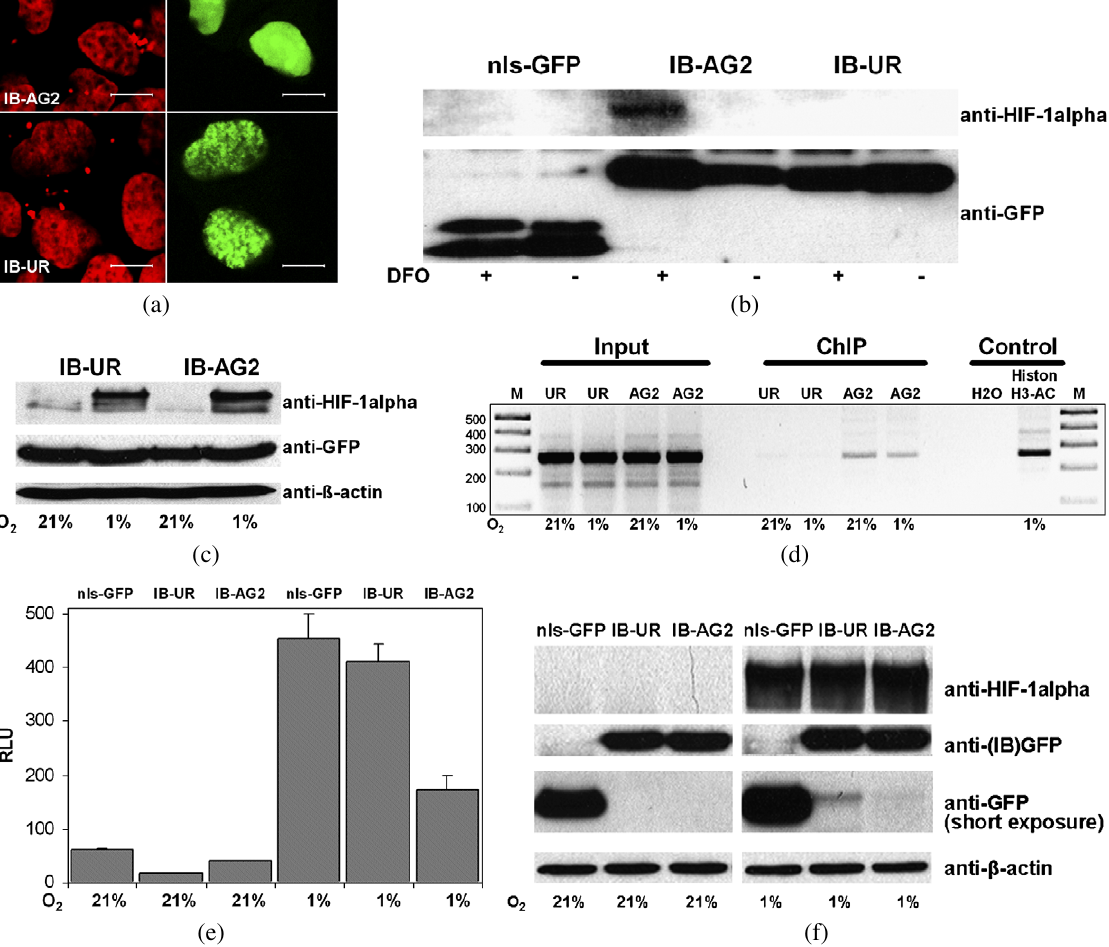
Fig. 4. Characterization of HIF intrabodies. (a) Immunofluorescence confocal microscopy with cultured U2OS cells transfected with either nuclear localized GFP fused IB-AG2 or control IB-UR intrabodies, DNA is stained with TO-PRO-3 (dark-grey/red ∗ ), scale bar = 10 µm. (b) Western blot analysis of Ni-NTA intrabody pull down of HeLa cell lysates transfected with IB-AG2, IB-UR or nls-GFP un – or stimulated with DFO. (c) U2OS cells were transfected with either IB-AG2 or IB-UR and 24 h after transfection exposed to normoxia (21%) or hypoxia (1% O 2 ) for 24 h. Separate culture dishes were used for either protein expression analysis for input with HIF-1 α , GFP and β -actin, or subjected to ChIP. (d) Ethidium bromide stained gel with PCR products from GFP ChIP isolates from IB-AG2 or control IB-UR transfected cells on endogenous EPO promoter. (H 2 O as a negative control and as positive control ChIP with anti-acetyl-Histone H3 antibody.) (e) HIF reporter assay with HRE-EPO-luc in U2OS cells transfected with IB-AG2 or control intrabody, IB-UR. IB-AG2 inhibits hypoxia induced HRE activity. All luciferase experiments were performed in triplicate and values were corrected for TK-renilla expression. Error bars represent mean + SD. (f) Corresponding immunoblot analyses to (e) of HIF-1 α and GFP fusions, with β -actin as a loading